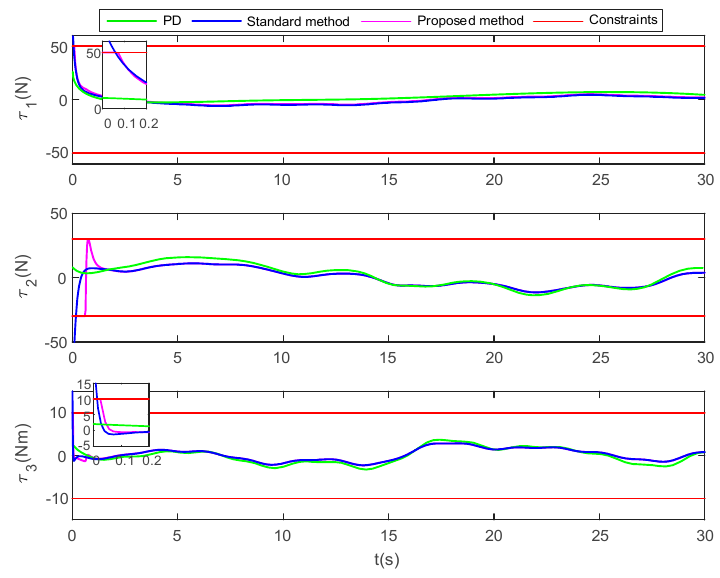
Figure 8. Control input under three control methods.